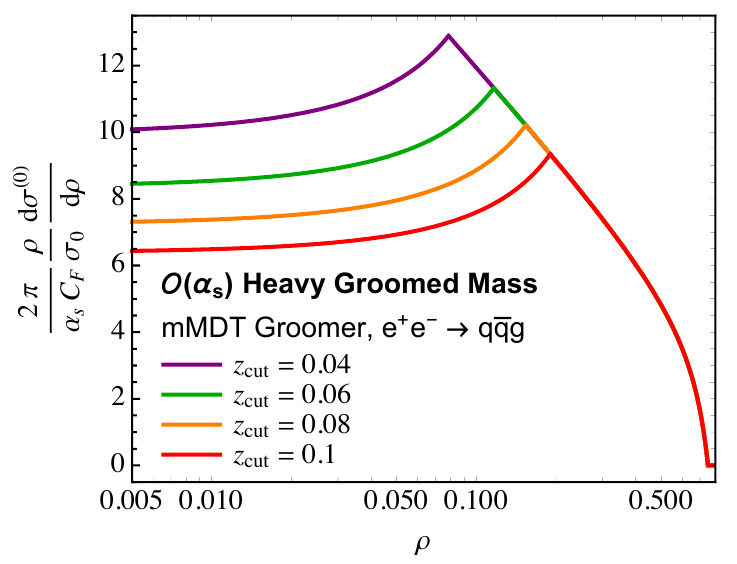
Figure 1 . Plots of the leading-order distribution of the groomed heavy hemisphere mass (cid:26) in e + e (cid:0) collisions, for values of the grooming parameter z cut = 0 : 04 ; 0 : 06 ; 0 : 08 ; 0 : 1. The cusp in these distributions lives at (cid:26) = 2 z cut (cid:0) z 2 cut